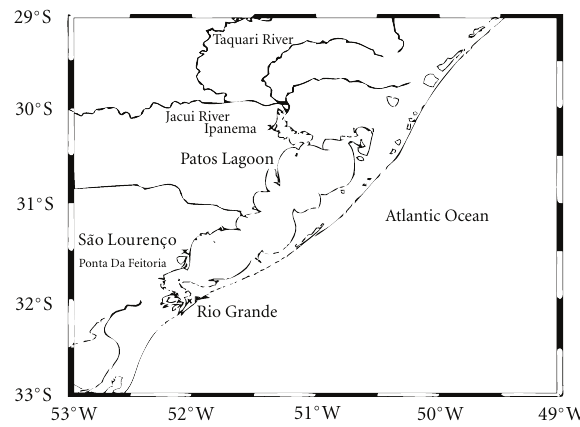
Figure 1: Patos Lagoon, main contributing rivers and water levels